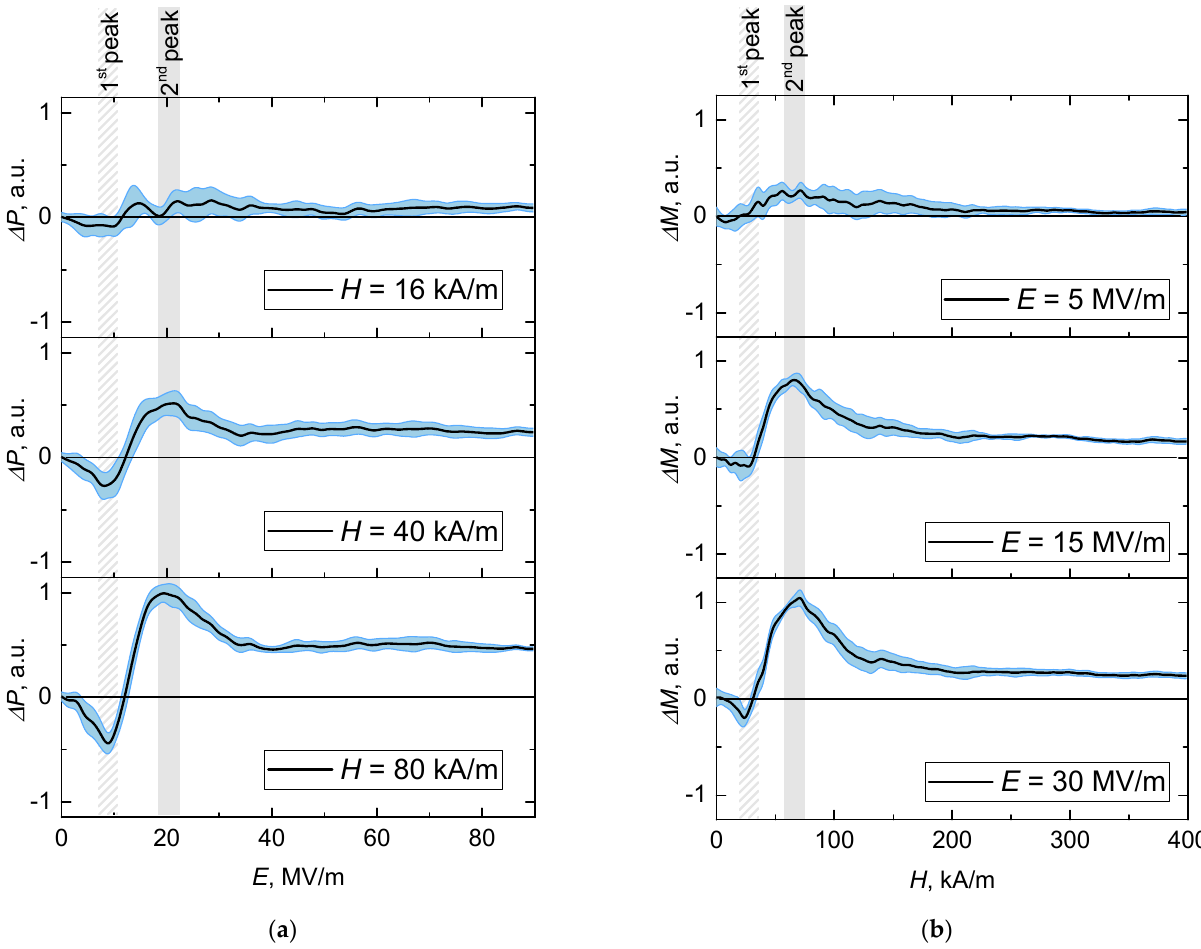
− P ( E ) and ( b ) inverse ∆ M ( H ) = M ( H ) H 0